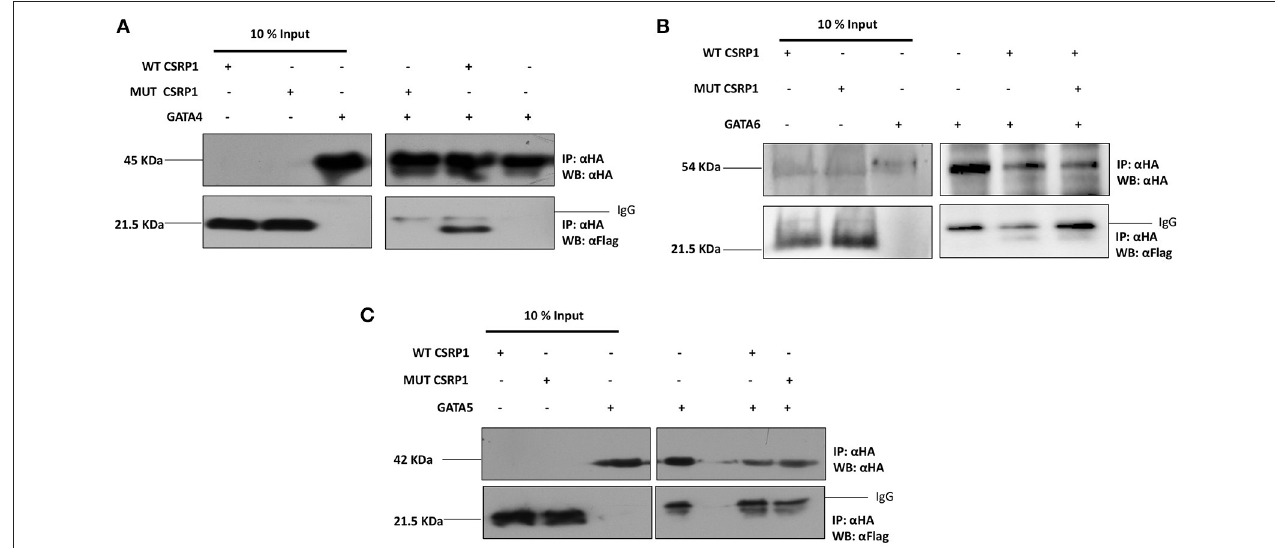
FIGURE 4 | Selective inhibition of the GATA4 physical interaction with CSRP1 by the p.E154Vfs*99 mutation. (A–C) The amount of the proteins used for immunoprecipitation was ten times that used in western blot. Nuclear lysates of CSRP1 protein were immunoprecipitated with anti-HA antibody and CSRP1 proteins were detected using anti-Flag antibody (arrows). After membrane stripping, subsequent western blot analysis using anti-HA was performed to detect GATA4, 5, and 6 proteins